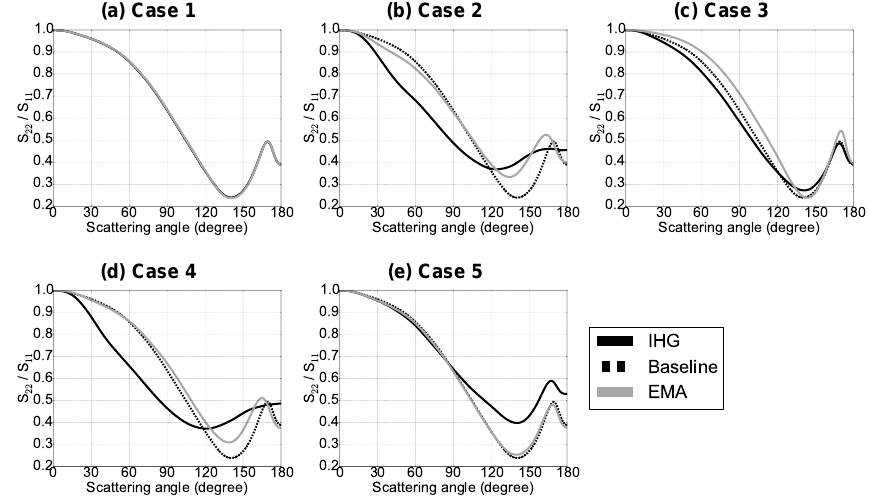
Figure 6. S 22 /S 11 values for the inhomogeneous (IHG), the baseline, and the homogeneous (EMA) versions of all five of the internal structure cases as a function of the scattering angle.